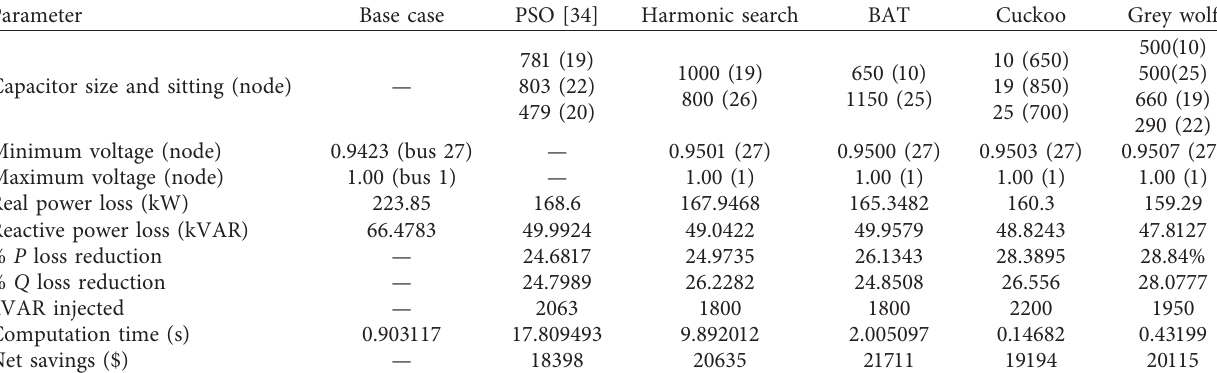
Figure 10: (a) Voltage profile IEEE-34 bus system. (b) Power loss (kW) at each node IEEE-34 bus system. Table 1: Results comparison of metaheuristic techniques on an IEEE-34 bus system.